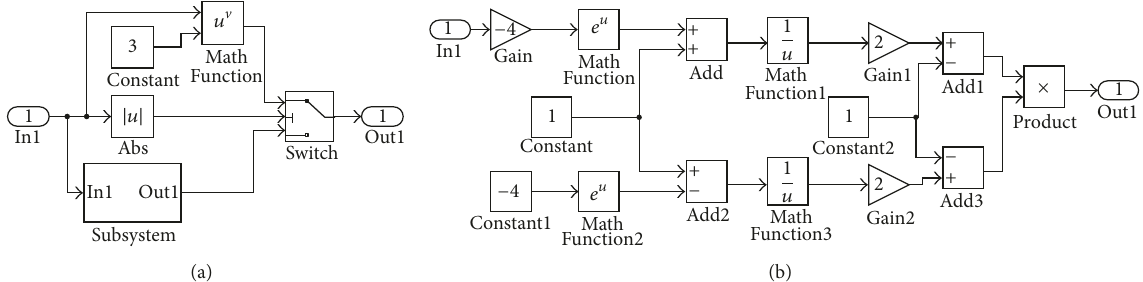
Figure 1: Block for the implementation of the power-sigmoid activation function (a) and its subsystem (b).